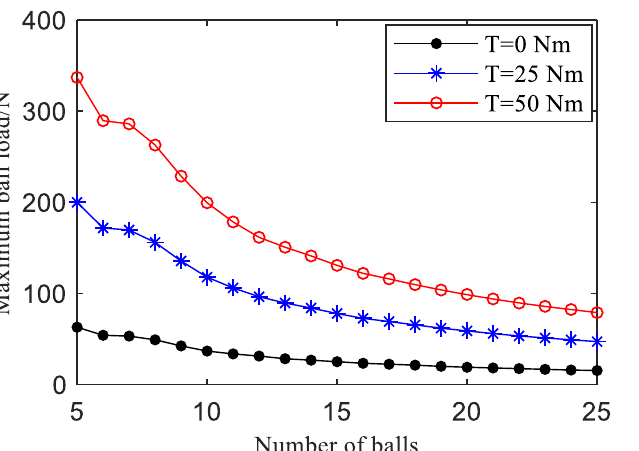
Fig. 8. Relationship of maximum ball load and number of balls under load.